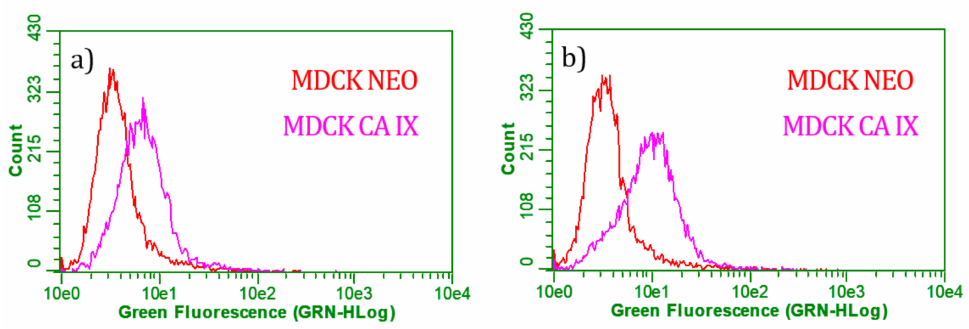
Cytometric analysis of ( a ) graphene oxide platforms with magnetic nanoparticles modified antibodies (GO-MNps-MAb) and ( b ) graphene oxide platforms with magnetic nanoparticles modified antibodies in the presence of 1–ethyl–3–(3–dimethylaminopropyl) carbodiimide (GO-MNps-EDC-MAb)